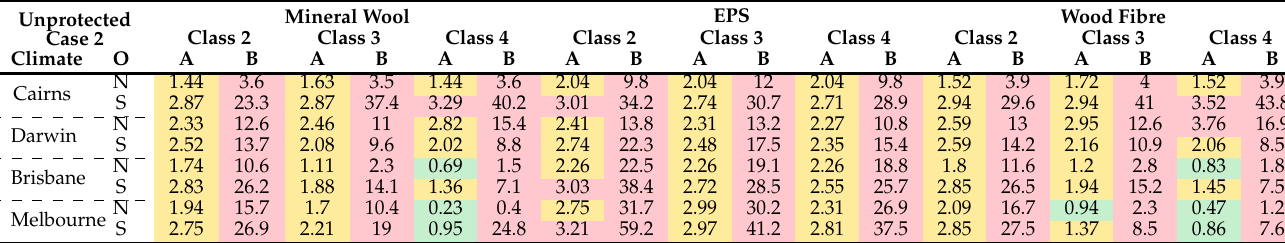
Table 11. Unprotected CLT results for split insulation. O (orientation). Performance criteria: A (mould growth index), B (corrosion rate). Classification of WRB: Class 2, 3, and 4 (vapour permeance). Green (pass), red (fail), or yellow (further investigation).